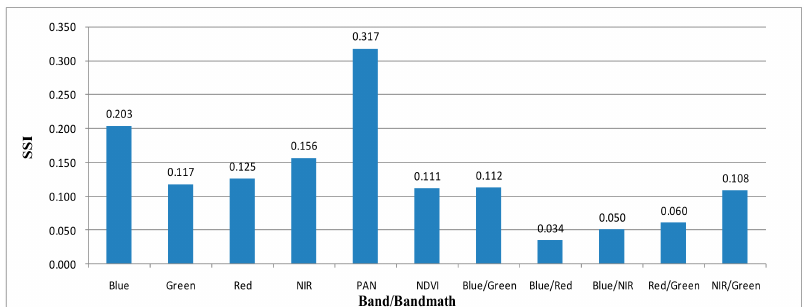
Figure 6. SSI for LATTICs in Miran